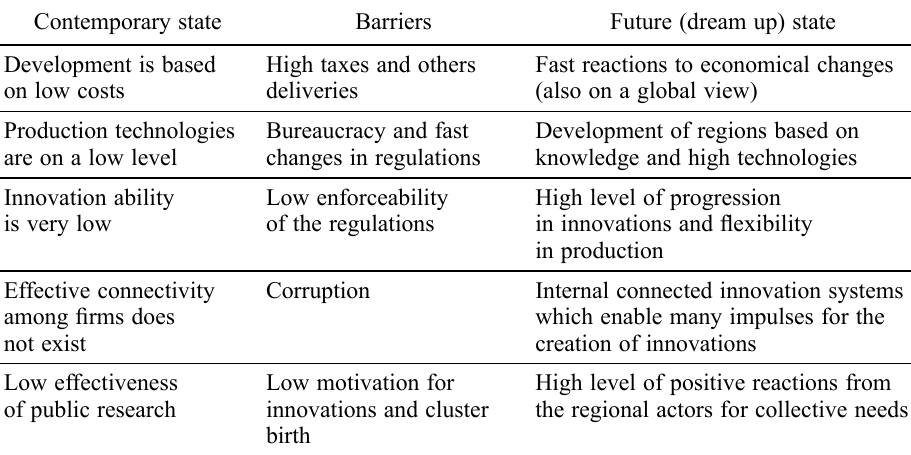
Table 1. The shift between the contemporary and future state in regional policy Contemporary state Barriers Future (dream up) state Development is based High taxes and others Fast reactions to economical changes on low costs deliveries (also on a global view) Bureaucracy and fast Development of regions based on changes in regulations knowledge and high technologies High level of progression in innovations and flexibility in production Corruption Internal connected innovation systems which enable many impulses for the creation of innovations Low motivation for High level of positive reactions from innovations and cluster the regional actors for collective birth